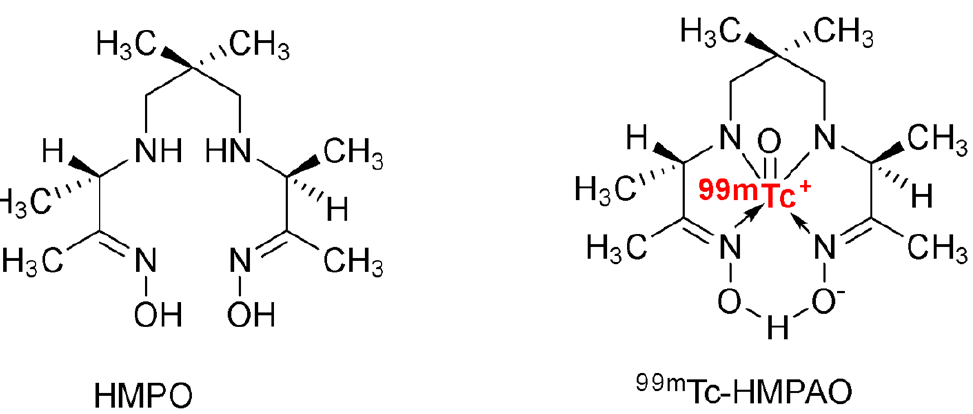
Figure Figure 4. Hexamethylpropylene amine oxime (HMPAO) and its technetium radiolabeled derivative 99m Tc-HMPAO.